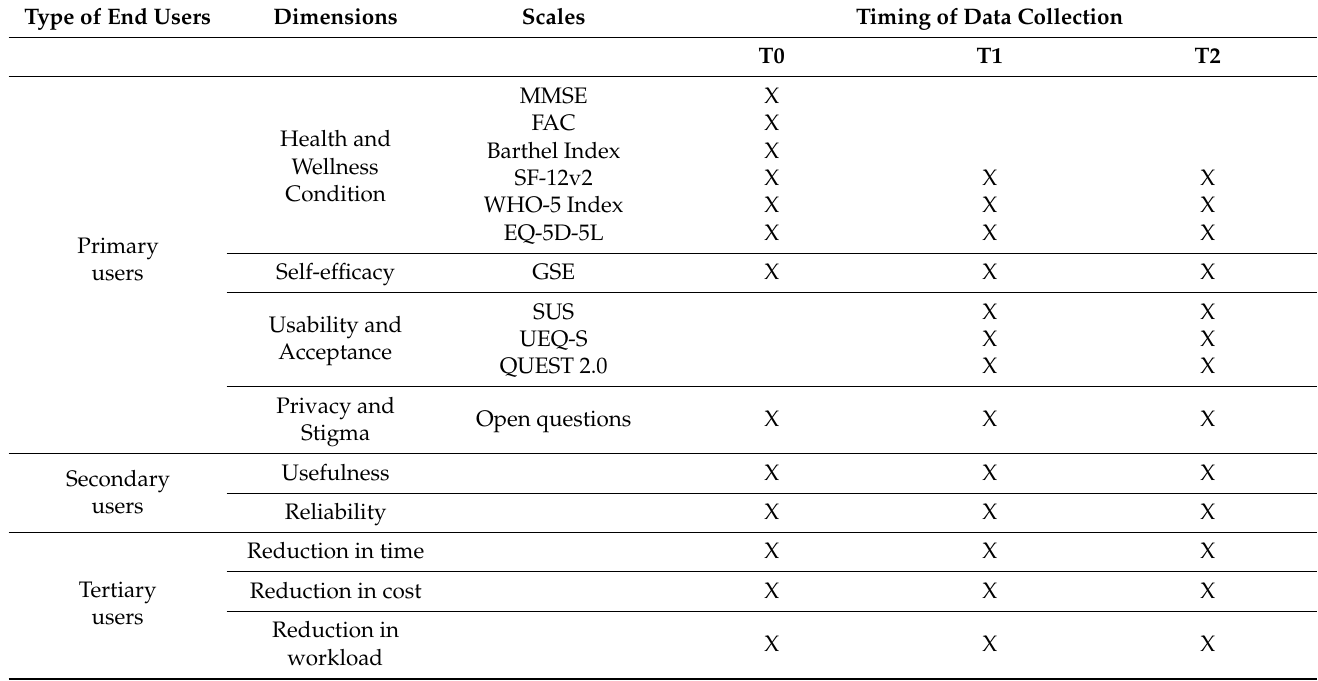
Table 2. Dimensions and measures of the evaluation study for all the